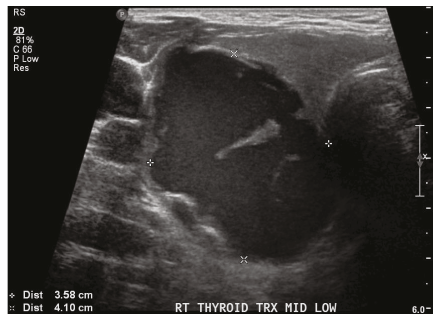
Figure 1: Ultrasound showing the parathyroid mass.